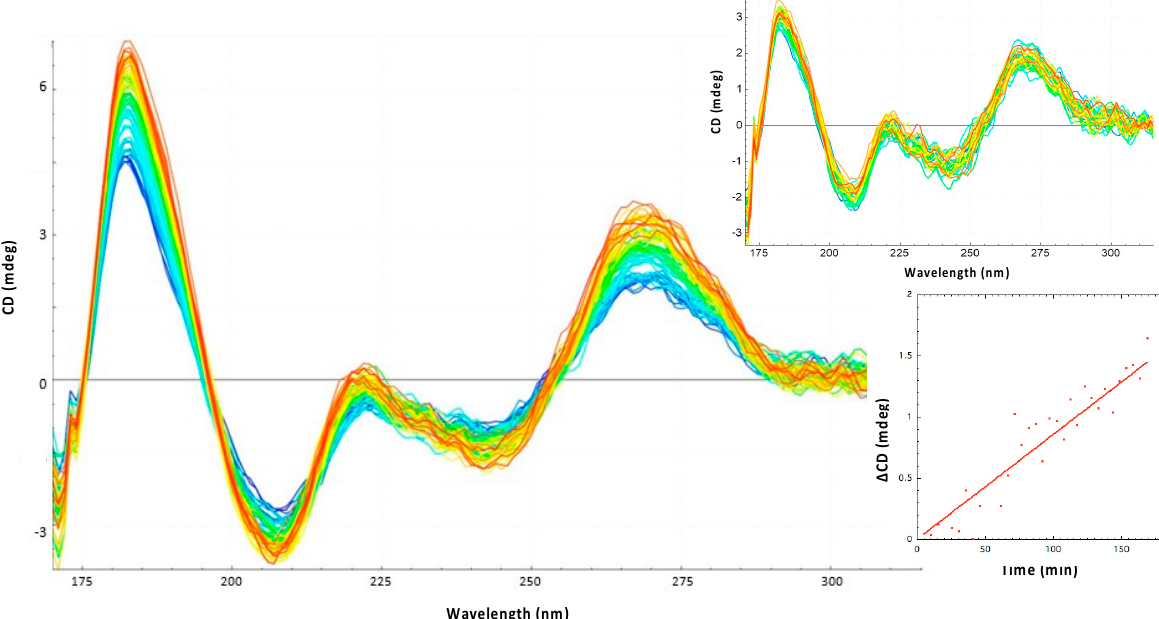
Figure 5. Observation of DsrA core stabilization by Hfq-CTR using SRCD (from blue t = 0 min to red t = 300 min). Inset top: control without the CTR, no significant stabilization is observed without the CTR. Inset bottom: kinetics of DsrA core stabilization by CTR. ∆ CD refers to CD at a specific time subtracted from CD at t = 0.